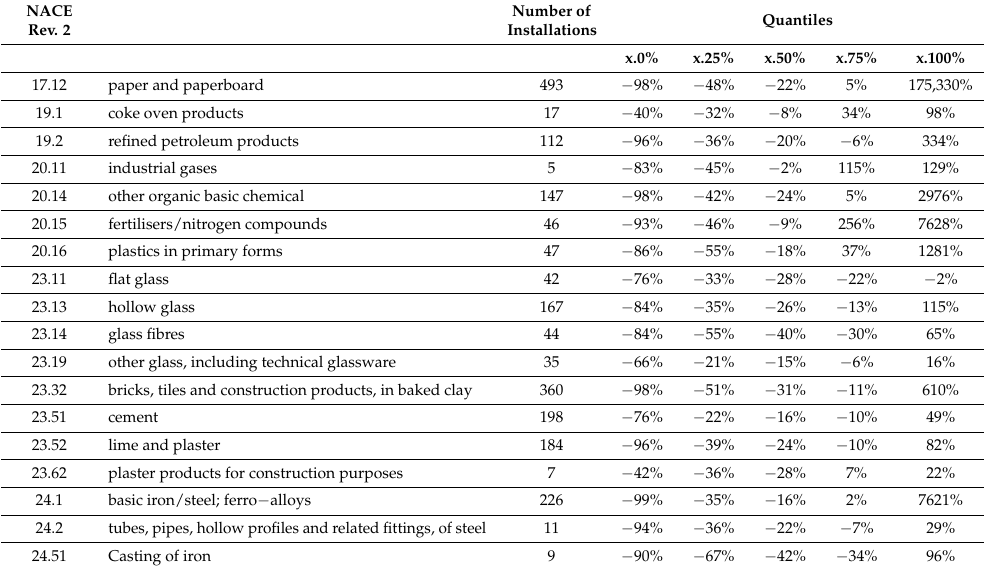
Figure 1. Allocation and Ratio of Allocation to Verified Emissions (A/V) in 2008/2013 by NACE Code. Note: For the list of NACE codes, see Table 3. Table 3. Sample size and distribution of the average allocation change in 2013 compared to the average of the 2nd Trading Period (TP) by NACE Code.